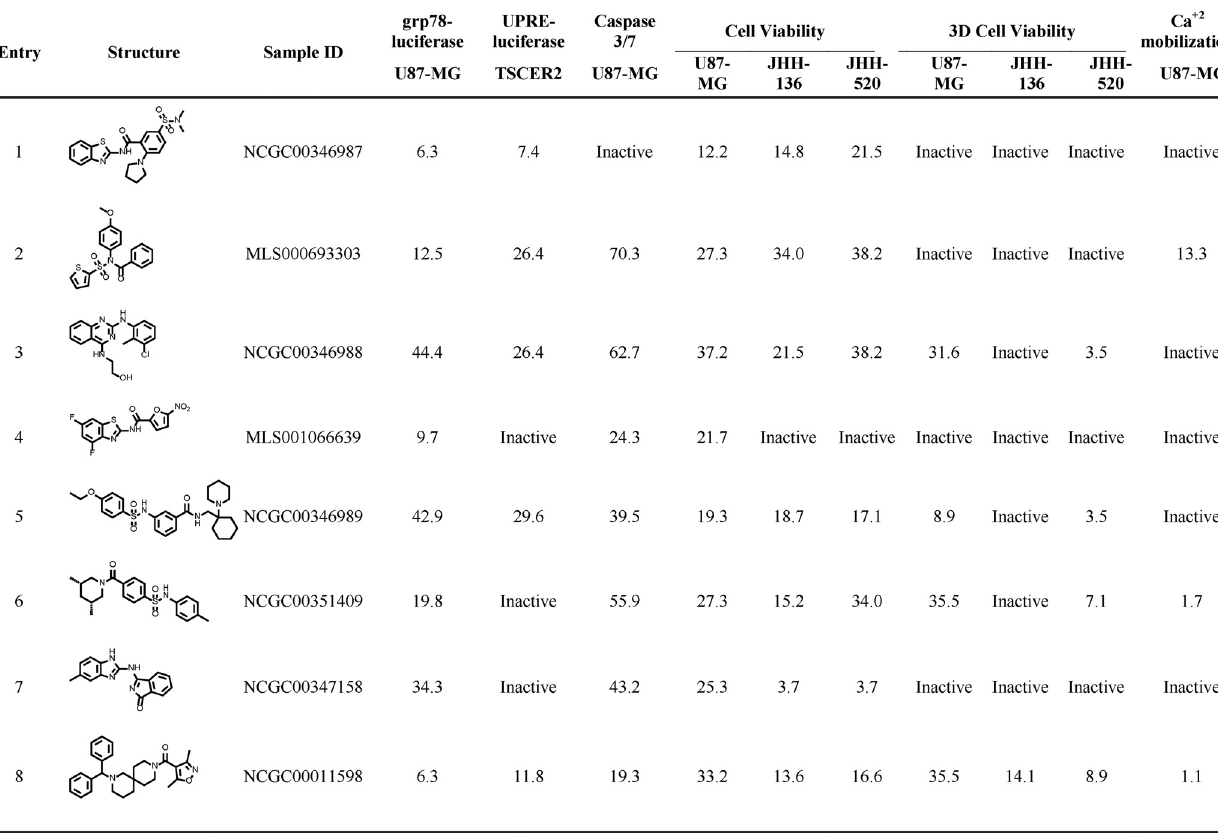
PLOS ONE | DOI:10.1371/journal.pone.0161486 August 29,